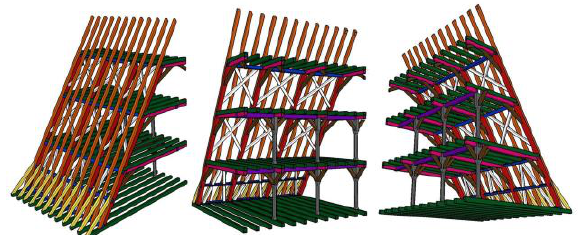
Figure 3: Structure of